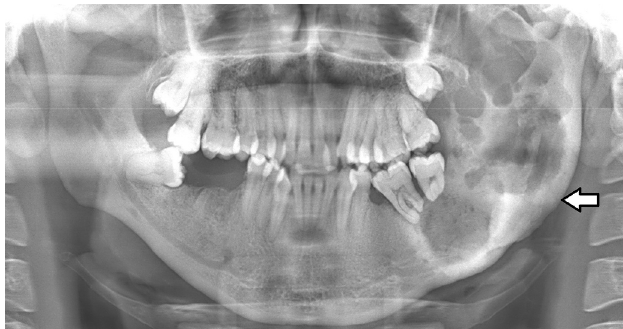
Fig. 1. Pantomograph showing both radiolucent and radiopaque appearance (mixed density) of an ameloblastoma in the left mandible.